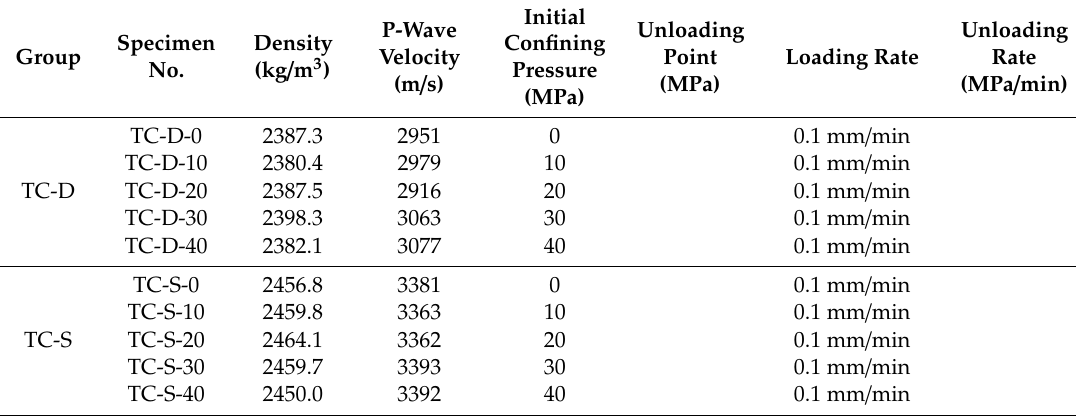
Table 2. Test scheme and physical parameters of sandstone specimens.